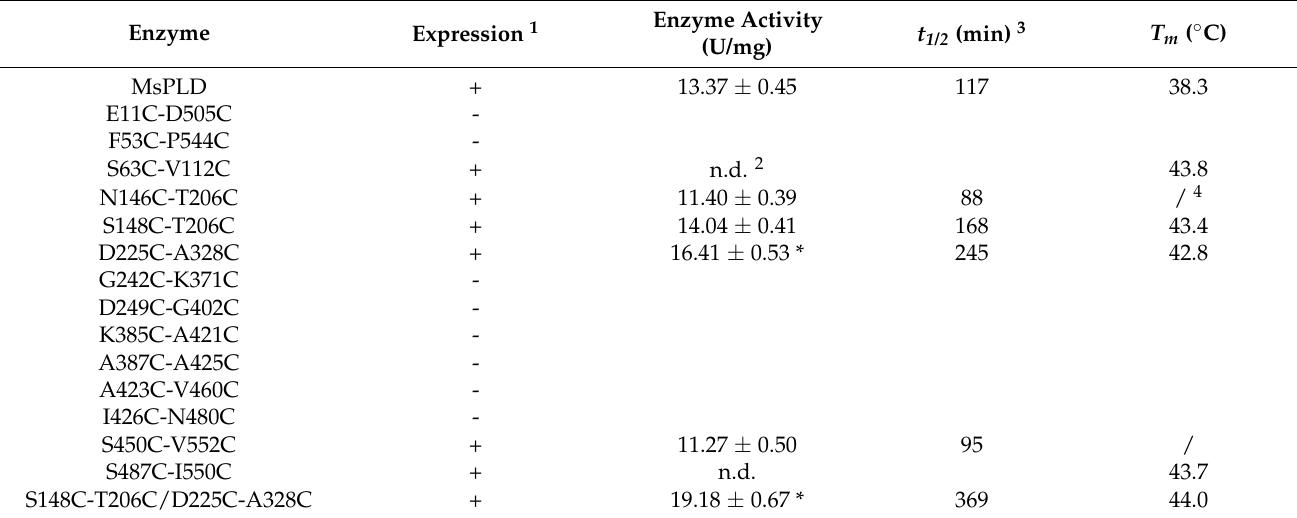
Table 1. Summary of the expression, stability, and activity of various MsPLD